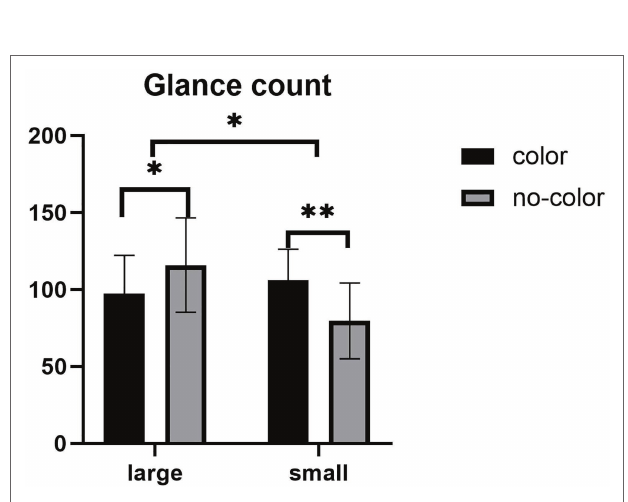
FIGURE 4 | Mean of glance count. Error bars represent standard errors of the means ( * p < 0.05, ** p < 0.01).